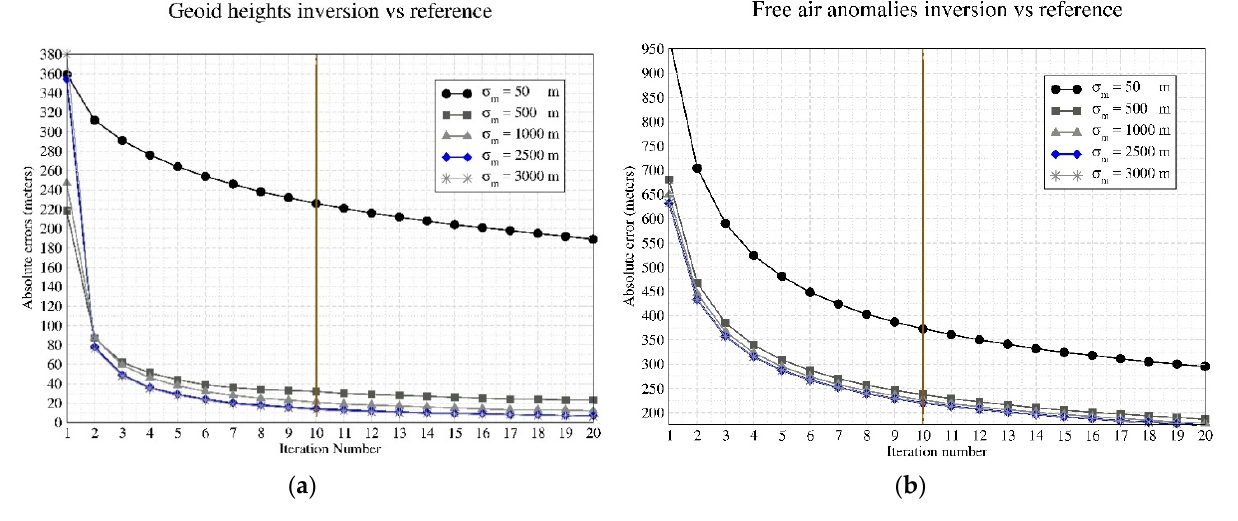
Figure 6. Absolute errors for variable σ m in the case of: ( a ) geoid heights inversion versus reference bathymetry; ( b ) free-air anomalies versus the reference bathymetry. Convergence to a stable solution is reached after 10 iterations (vertical line).